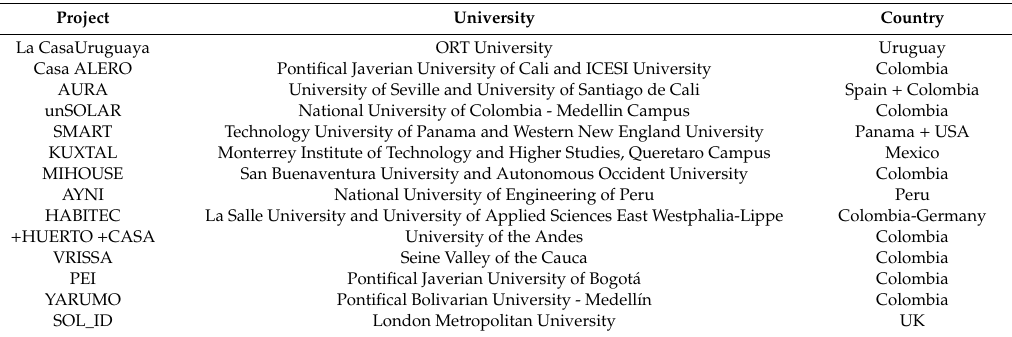
Table 1. Teams participating in first Solar Decathlon in Latin